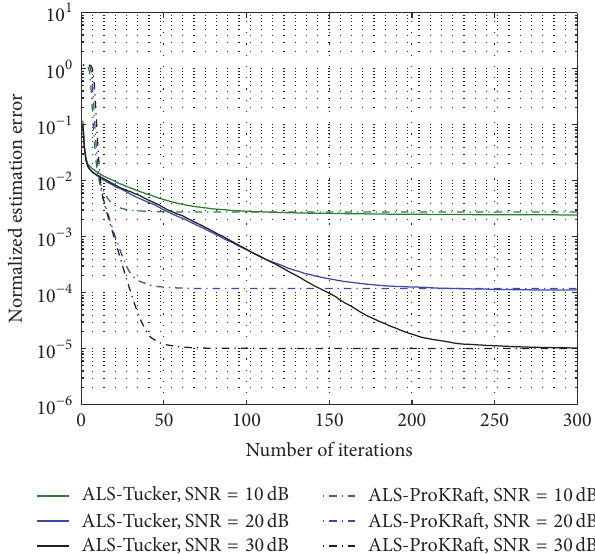
Figure 4: Convergence of the ALS-Tucker and ALS-ProKRaft algo-